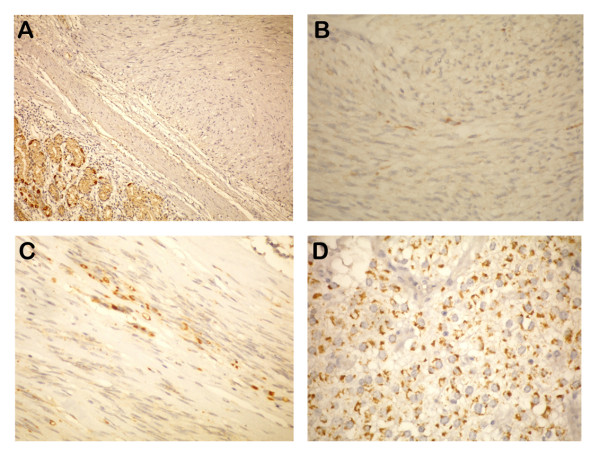
A) OMS score (-), B) OMS score (1+), C) OMS score (2+), D) OMS score (3+) staining paterns in GIST's.